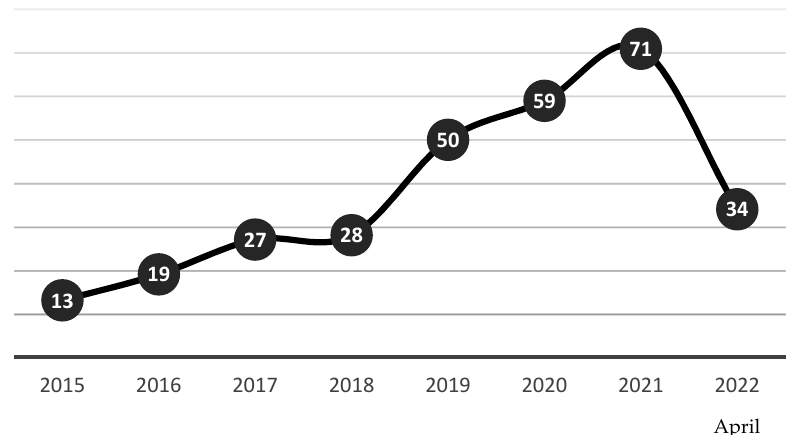
Figure 2. Annual scientific production on the green financing domain (articles). Source: Authors’ own compilation.